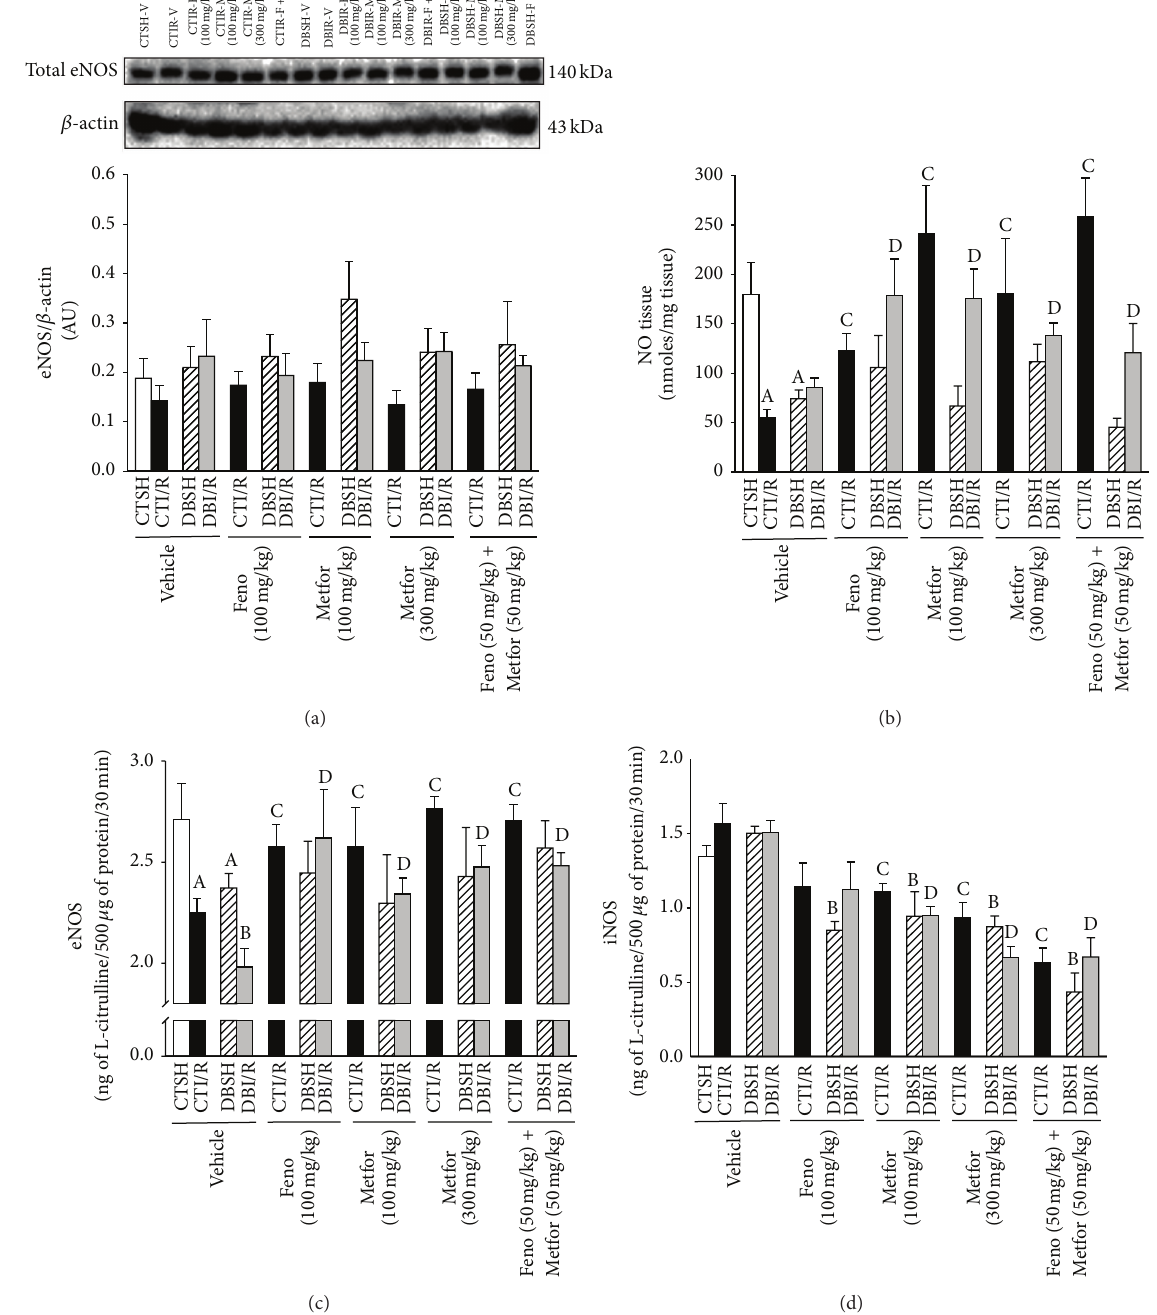
Figure 9: Effect of fenofibrate, metformin, and their combination on nitric oxide system. (a) The expression of endothelial nitric oxide synthase (eNOS) was analyzed by Western blot in the left ventricle of control- (CT-) and diabetic- (DB-) rats, subjected to sham (SH) or ischemia/reperfusion (I/R) injury, receiving 14 days of either vehicle, fenofibrate (F or Feno, 100 mg/kg), metformin (M or Metfor, 100 or 300 mg/kg), or Feno (50 mg/kg) + Metfor (50 mg/kg) and (b) tissue NO production and the activity of (c) eNOS and (d) iNOS. The bars represent the mean ± SEM of 4–6 different experiments. A 𝑃 < 0.05 versus CTSH-Vehicle, B 𝑃 < 0.05 versus DBSH-Vehicle, C 𝑃 < 0.05 versus CTI/R-Vehicle, and D 𝑃 < 0.05 versus DBI/R-Vehicle two-way ANOVA followed by Duncan’s post hoc